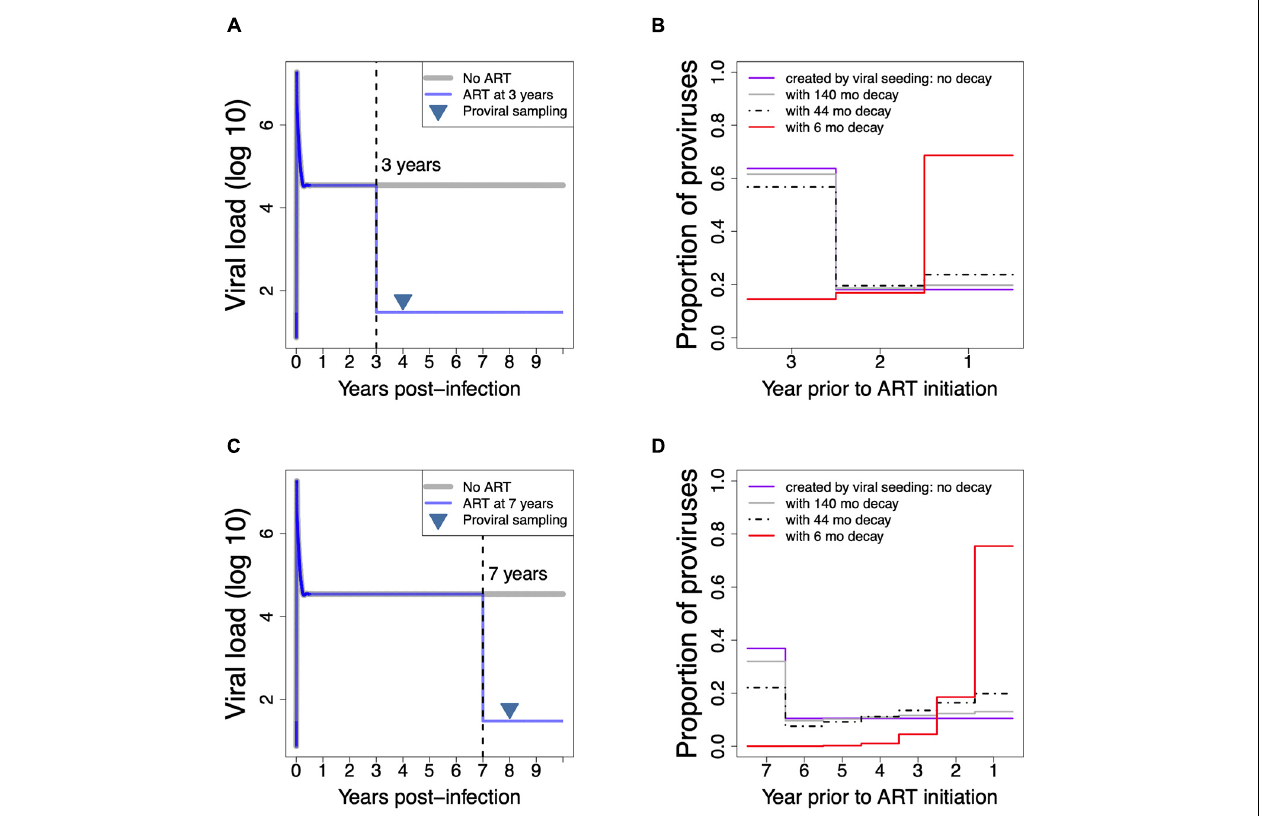
FIGURE 3 | Using a mathematical model of HIV infection to demonstrate how untreated HIV infection duration and proviral decay rate shape proviral composition on ART. (A) Model-produced plasma viral load dynamics in a hypothetical individual who initiated ART 3 years after infection (blue line), where proviral DNA was sampled 1 year later (inverted triangle). Note that the proviral sampling time-point is illustrative only: as proviral seeding in the model ceases at ART initiation but decay proceeds at a constant rate, and because proviral compositions are depicted as proportions of proviruses remaining from each year of creation, model predictions would be the same regardless of when the proviral pool is sampled on ART. (B) Model-predicted proviral compositions on ART for the hypothetical individual shown in A , depicted in terms of the proportions of proviruses remaining from each year of creation, under conditions of no decay (purple line), under slow decay rates of 140 months (gray line) and 44 months (dotted black line) that represent published half-lives of proviral DNA and the replication-competent reservoir during ART, respectively (Siliciano et al., 2003; Golob et al., 2018), and under a rapid decay rate of 6 months (red line). (C) Same as panel A , but for a hypothetical individual who initiated ART 7 years after infection. (D) Model predicted proviral compositions on ART for the hypothetical individual shown in C , under various rates of decay.